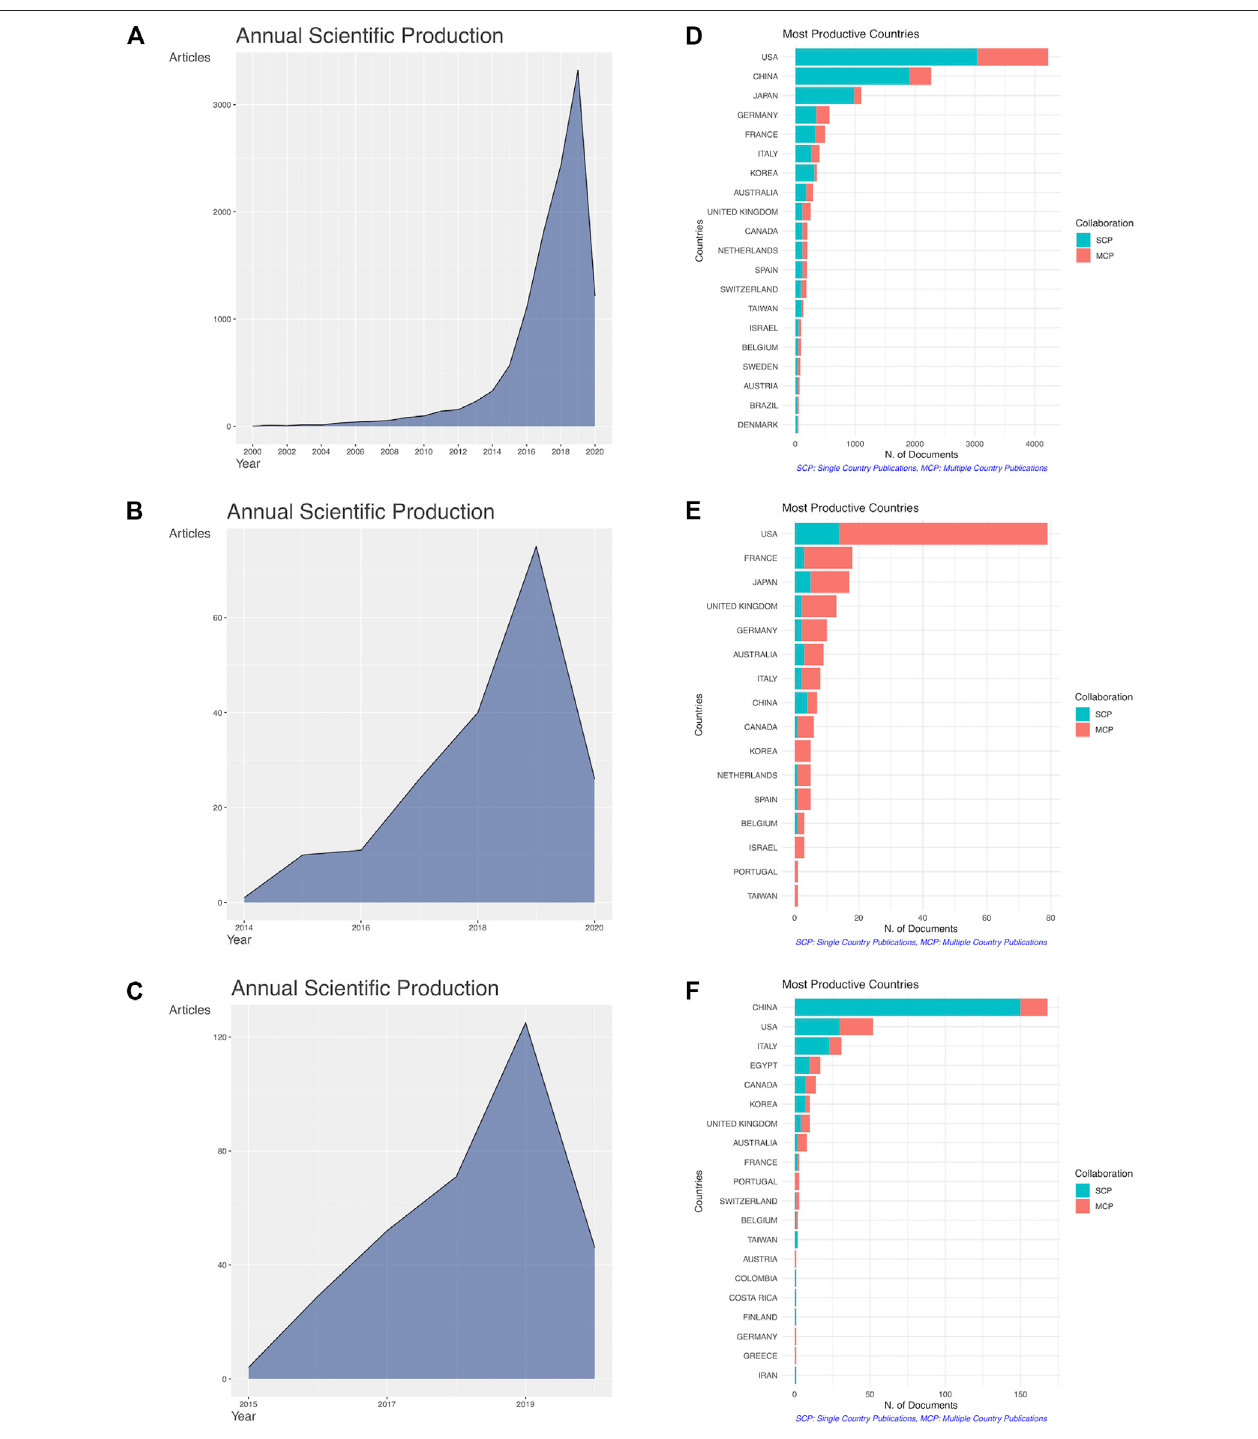
FIGURE 2 | The growth trend in publication number and the international cooperation of countries. Annual scienti fi c production of the articles on the PD1/PDL1 molecule (A) , RCT of anti-PD1/PDL1 (B) and meta-analysis of anti-PD1/PDL1 (C) . Top 20 productive countries and their international collaboration on the PD1/PDL1 molecule (D) , RCT of anti-PD1/PDL1 (E) and meta-analysis of anti-PD1/PDL1 (F) . The blue and red lines represented single country publication (SCP) and multiple countries publication (MCP).